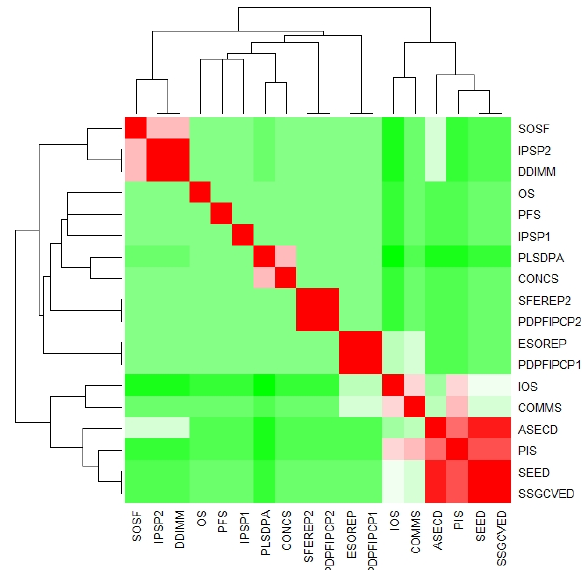
Figure 6. Heatmap reflecting dependencies between different phases and stages of the Fort Bema project.